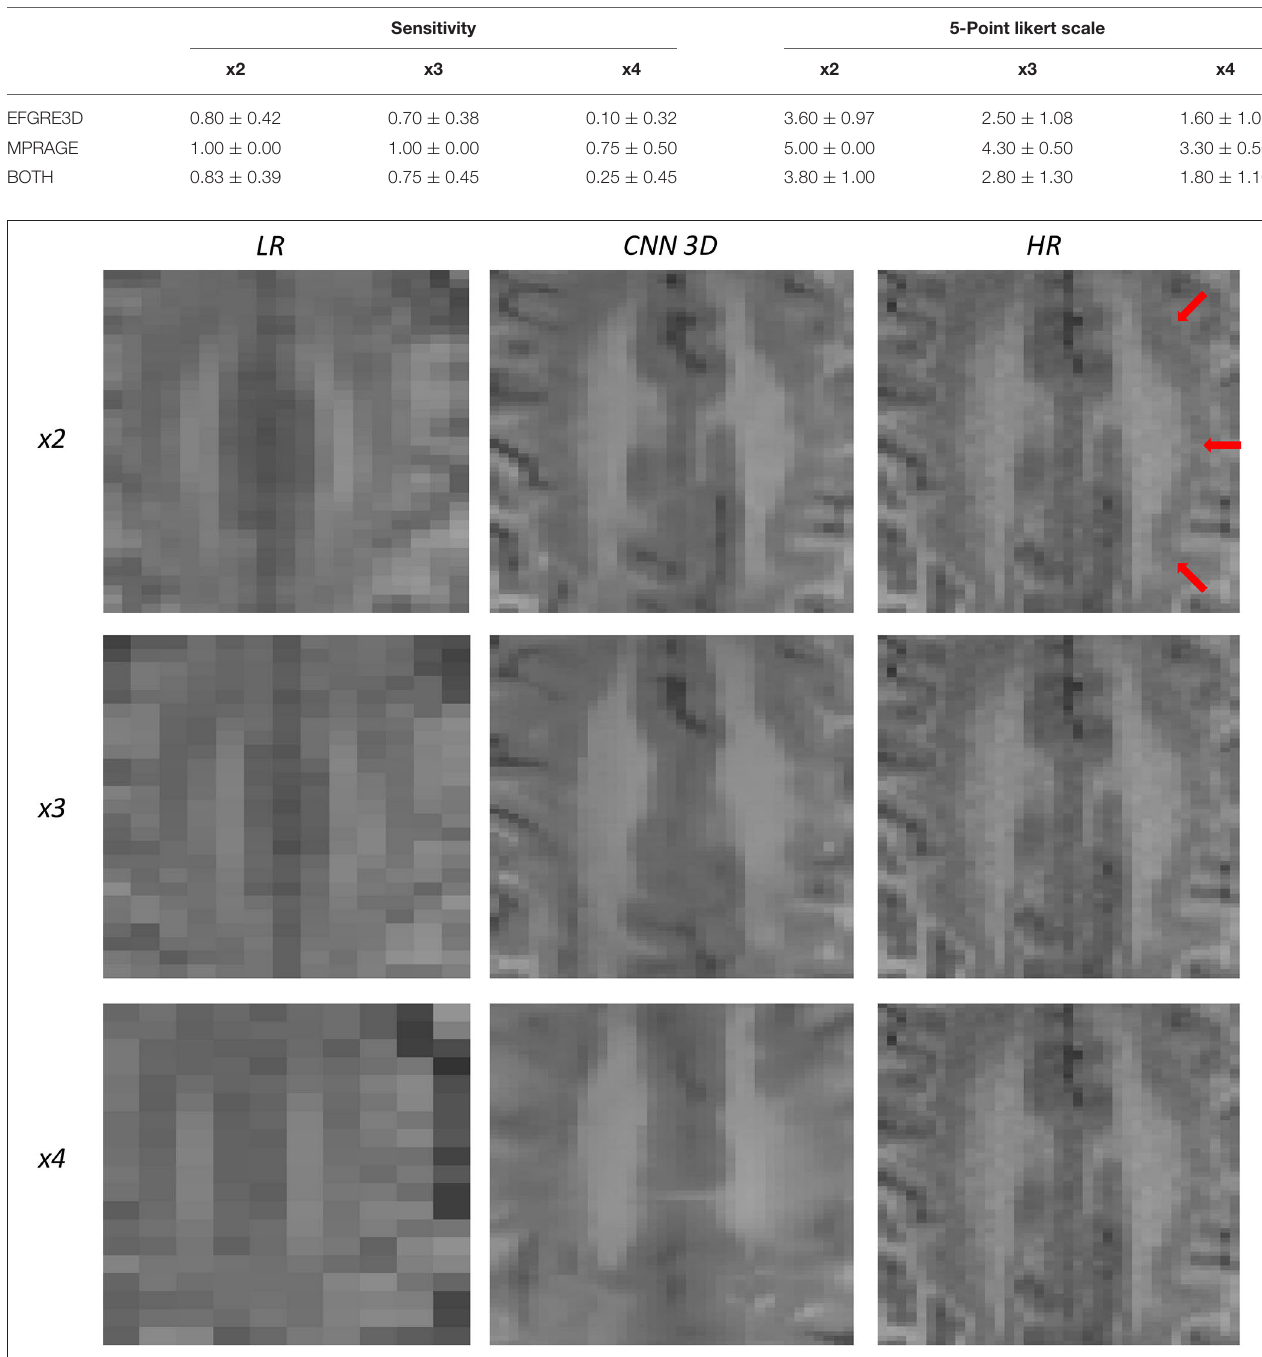
FIGURE 10 | Results of both CNN methods on three scaling factors of super-resolution on images of a patient with dysplasia. A specific region of a slice is shown, with the three red arrows pointing to a lesion.